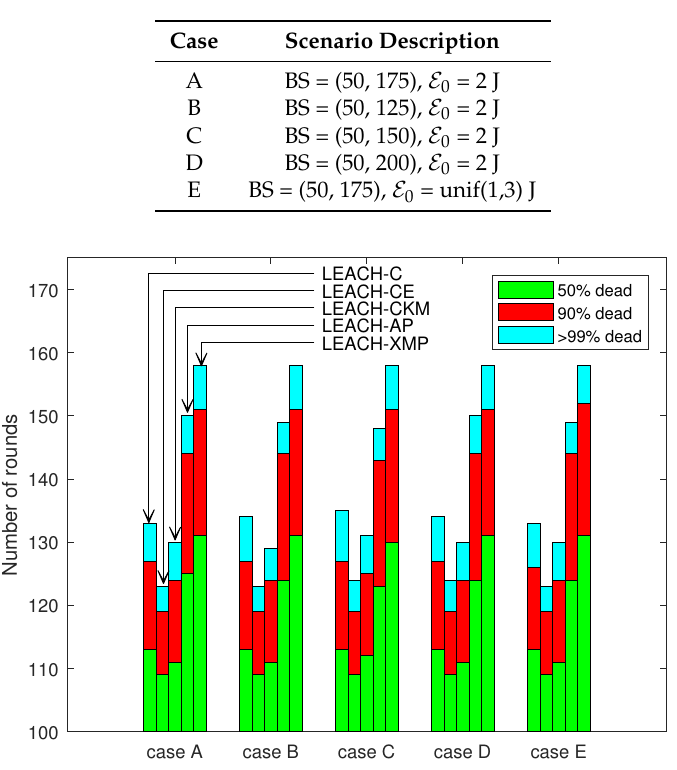
Table 3. Simulation Scenarios.